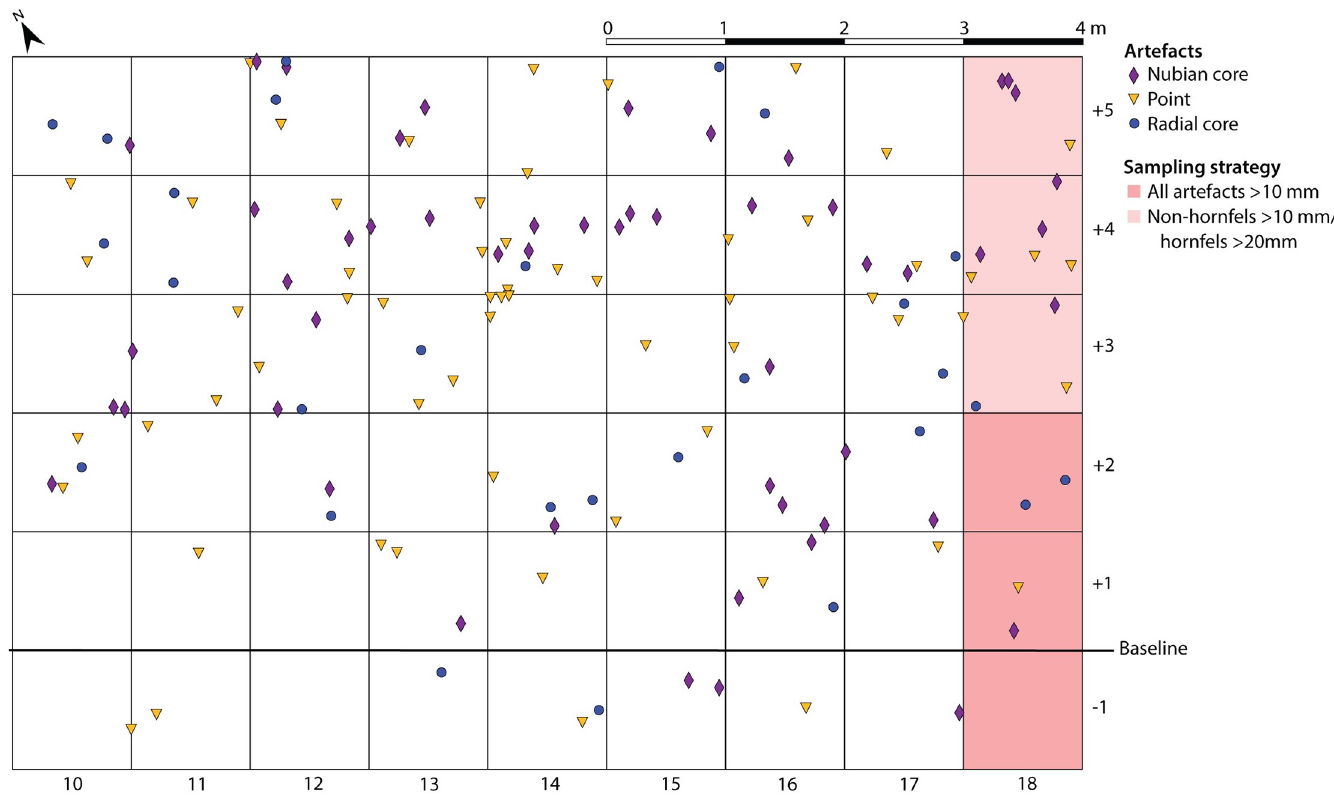
Fig 4. Schematic of the 2015 sampling grid showing mapped Nubian cores, points and radial cores.